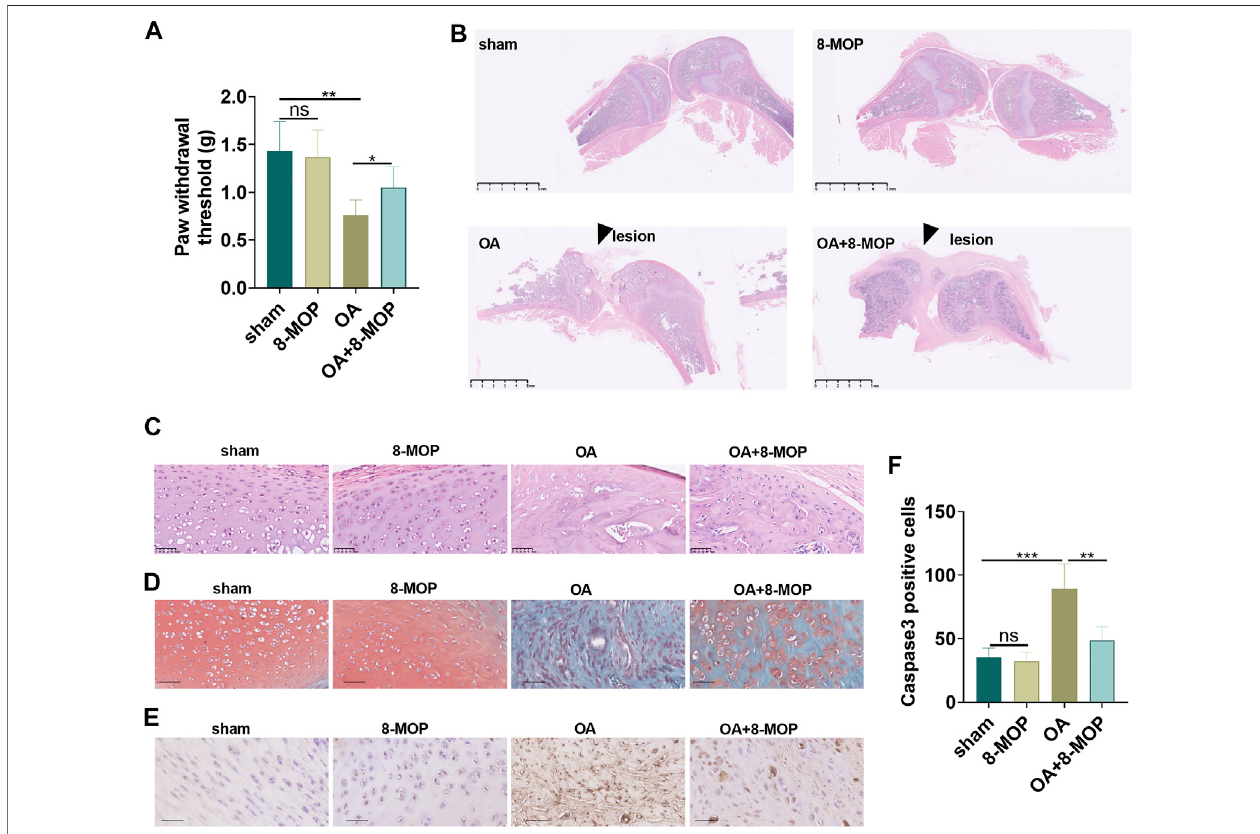
FIGURE5| 8-MOPimprovedthepainandarticularcartilageinjuryinOArats.TheWistarratOAmodelwasestablishedbyintraarticularinjectionof4%papain.Rats were divided into four groups: The sham group, the 8-MOP (30 μ mol/kg, i.p.) group, the OA group, and the OA + 8-MOP (30 μ mol/kg, i.p.) group. The rats were sacri fi cedandthekneejointtissueswereusedforhistopathologicalexamination. (A) .ThePWTwasmeasuredtoassessthelevelofbonepaininrats. (B – C) .HEstaining was performed for evaluating the histopathological changes of knee joint of rats. (B) showed the gross image of HE staining (scale bar (cid:1) 5 mm), and (C) showed that enlarged image of the OA site (200 × , scale bar (cid:1) 50 μ m). (D) . Safranin O/fast green staining was performed on the cartilage tissue sections of the knee joint of rats (200 × , scale bar (cid:1) 50 μ m). (E – F) . The number ofCaspase3-positive cells wasdetermined byIHC toevaluate thelevel oftissue cell apoptosis (200 × , scale bar (cid:1) 50 μ m). The apoptotic cells (labeled by Caspase3) were counted. ns p > 0.05, * p < 0.05, ** p < 0.01, *** p < 0.001. ( n (cid:1)